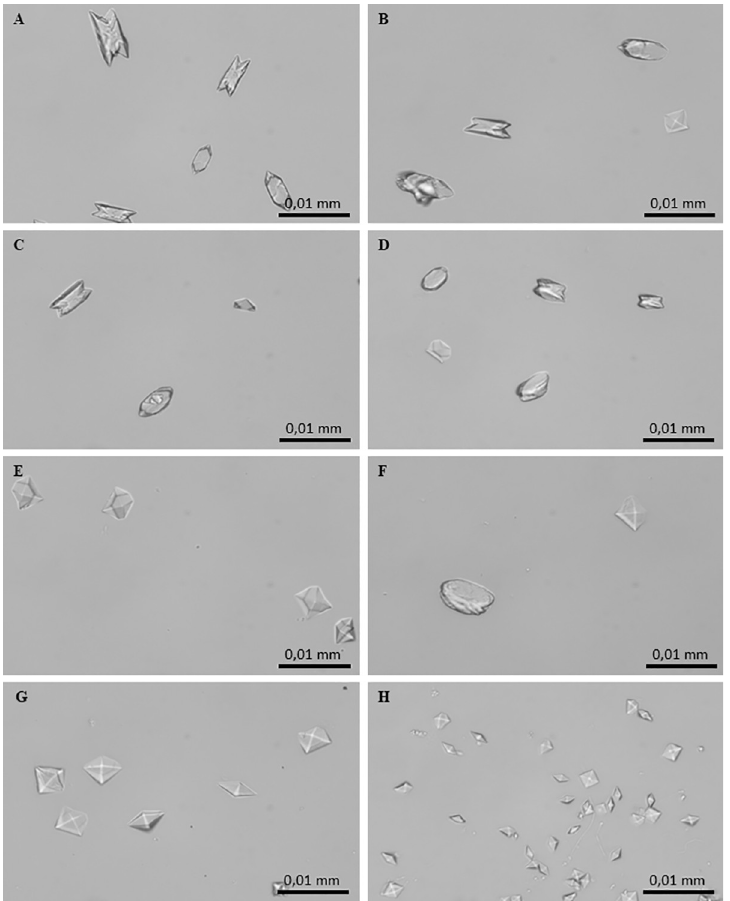
Fig 13. Light micrographs of CaOx crystals grown in the absence and presence of C . officinarum solubilized component(s) in increasing concentrations. (A) and (B) Controls; (C) 1.2 μ g dw/ml; (D) 2.3 μ g dw/ml; (E) and (F) 4.7 μ g dw/ml; (G) 9.4 μ g dw/ml; (H) 18.7 μ g dw/ml. Magnification was 400x for all panels.